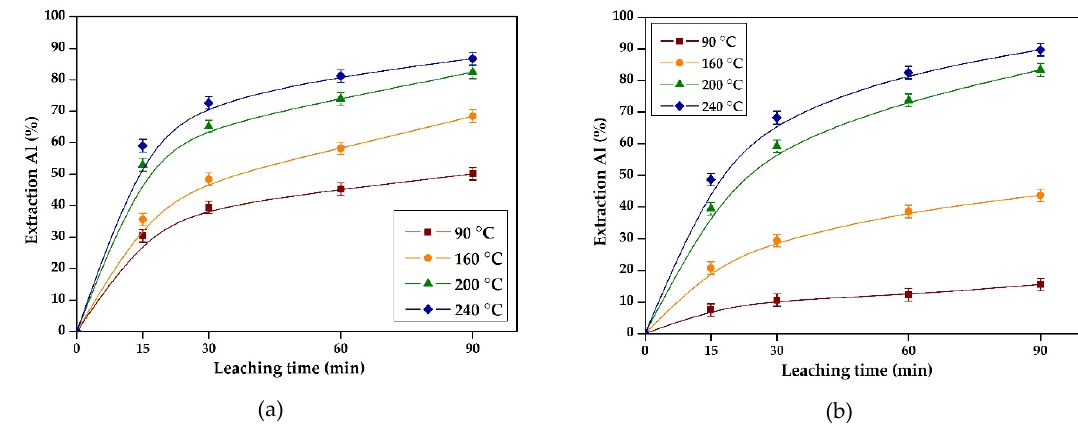
Figure 6. Effect of leaching time and temperature for Al extraction from raw ESP dust ( a ), from water- leached ESP dust ( b